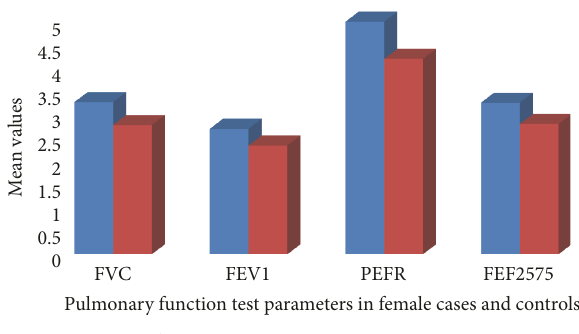
Figure 1: Mean values of pulmonary function tests in hypertensive (cases) and nonhypertensive (controls) females at Zewditu Memo- rial Hospital, Addis Ababa, Ethiopia, 2017.